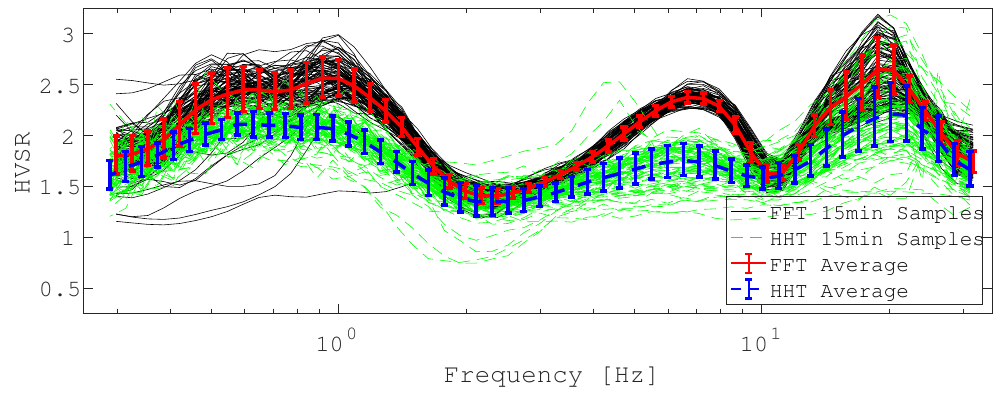
Figure 6. EJDN results for FFT- and MEMD-based